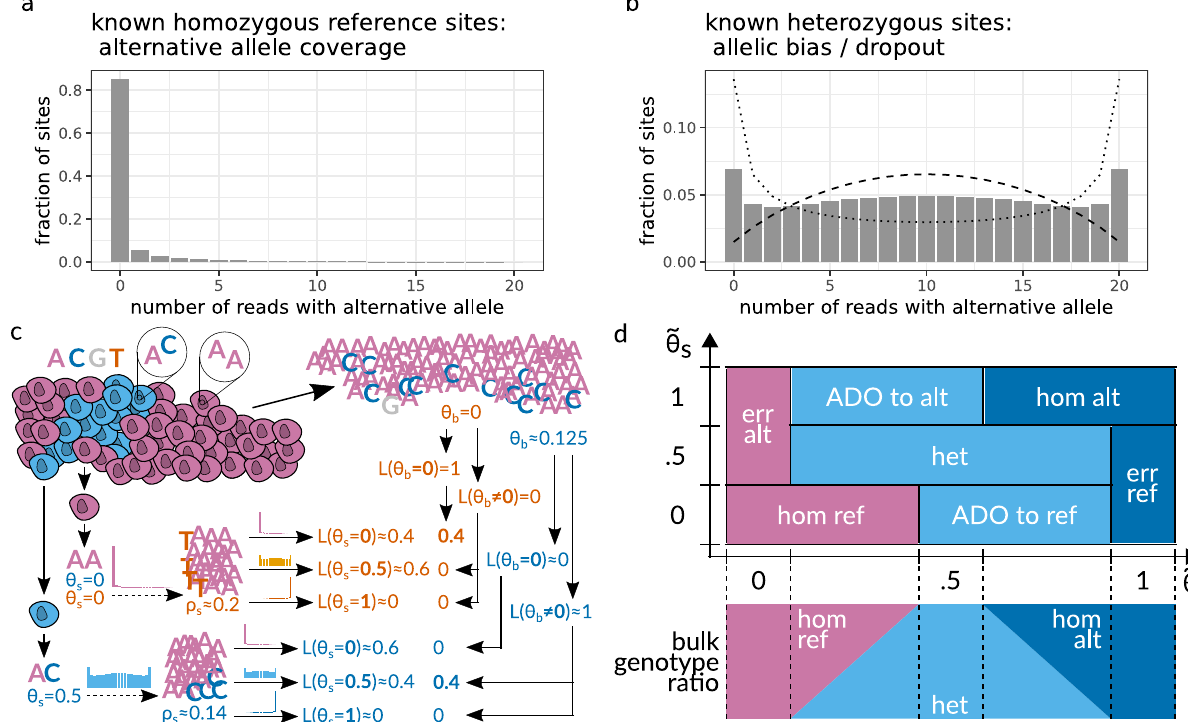
Fig. 3 High-level overview of ProSolo ’ s variant calling model. a , b Exemplary alternative allele read count distributions for sites covered by 20 reads, as derived by Lodato et al. 22 Homozygous reference sites in a are assumed to follow a beta-binomial distribution; sites heterozygous for the alternative allele in b are assumed to follow the linear combination of two symmetrical beta-binomial distributions (dotted and dashed lines). c Toy example of calling the same genomic site in two single cells from the same population that differ in their true underlying allele frequencies for alternative allele C (blue, θ s = 0 vs. θ = 0.5). Alternative nucleotide T (orange) is an ampli fi cation error. Empirical distributions in A and B account for the ampli fi cation bias, and likelihoods for s the alternative allele candidates from the bulk reduce the likelihoods of ampli fi cation errors, thereby correctly identifying both the error and the original true mutation. This is formalized with the model in D. d De fi nition of single-cell events based on ProSolo ’ s likelihood density estimates for the spectrum of true underlying alternative allele frequencies in the single-cell ( ~ θ s ) and the bulk ( ~ θ b ). The bulk is always assumed to be a combination of a maximum of two genotypes at a particular site, generating all possible θ b (bottom panel). The model further assumes that the bulk sample has suf fi cient coverage to capture somatic variants. ADO allele dropout, alt alternative, err error, het heterozygous, hom homozygous, ref